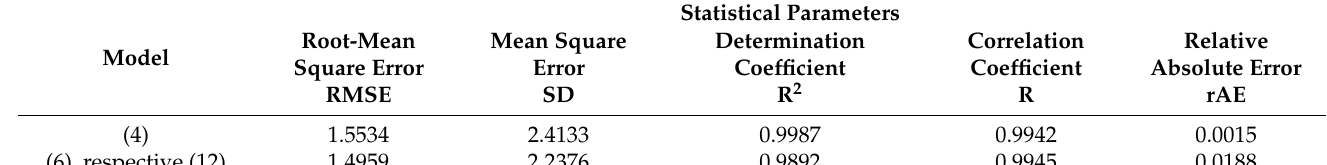
Table 4. Statistical indicators—comparative data using models (4) and (6).